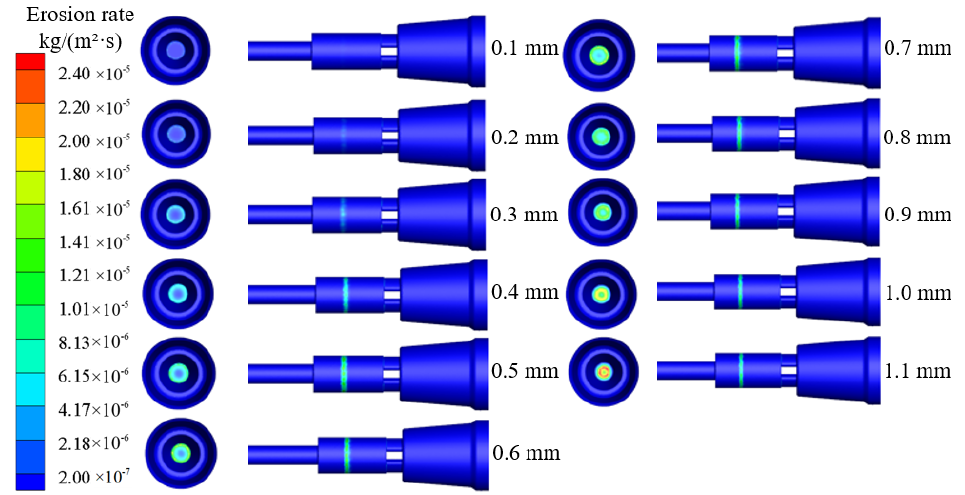
Figure 10. Erosion area changes with solid particle diameter.